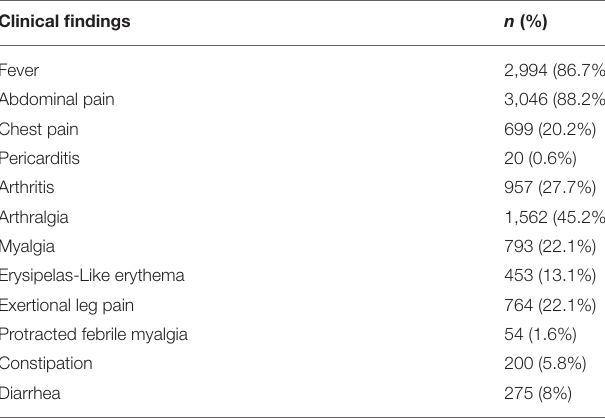
TABLE 1 | The clinical findings of the familial Mediterranean fever patients ( n = 3,454). Clinical findings